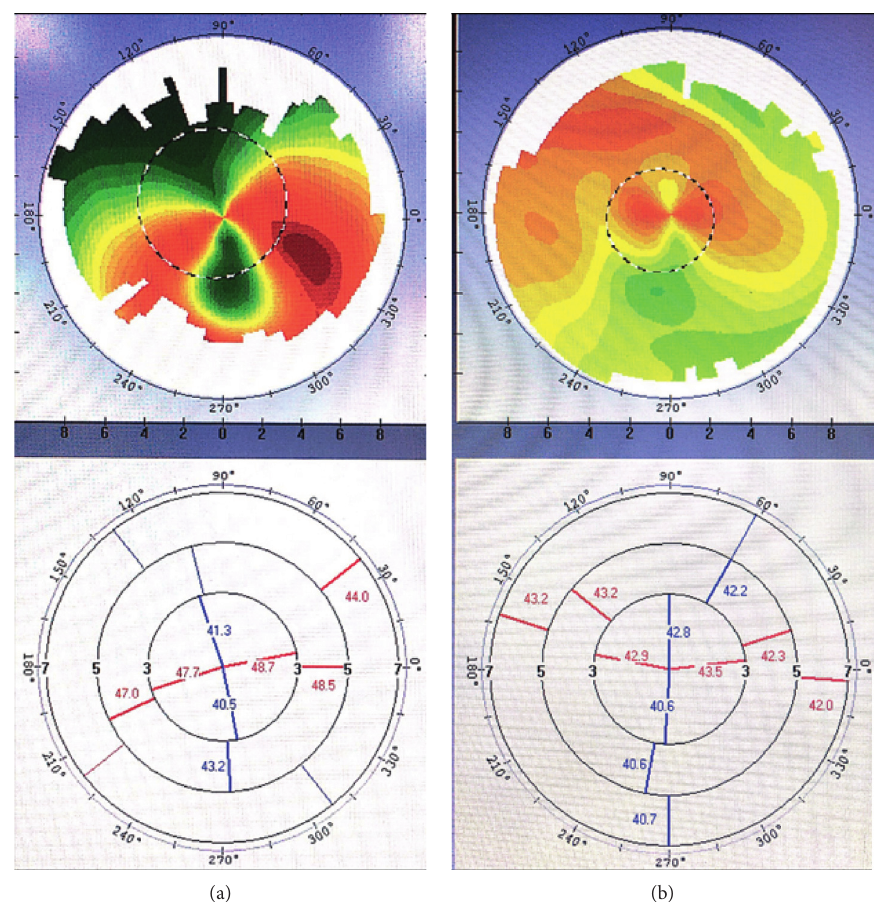
Figure 3: Corneal shape with an irregular periphery pattern. (a, b) Although the two main meridional lines in the central 3-mm zone are in an approximately vertical distribution, an irregular periphery was